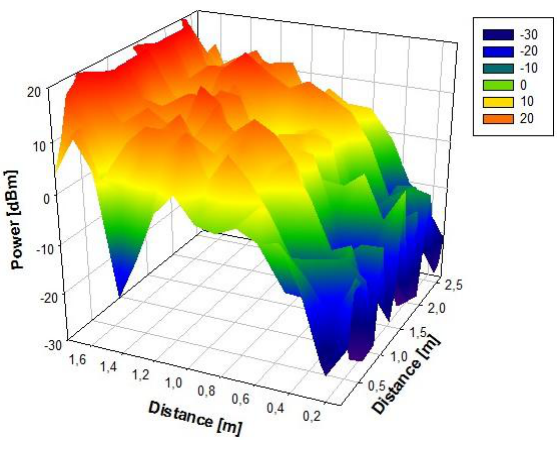
Figure 4. Volumetric view of simulated values of received power [dBm] on the second floor of containers seen from the side.